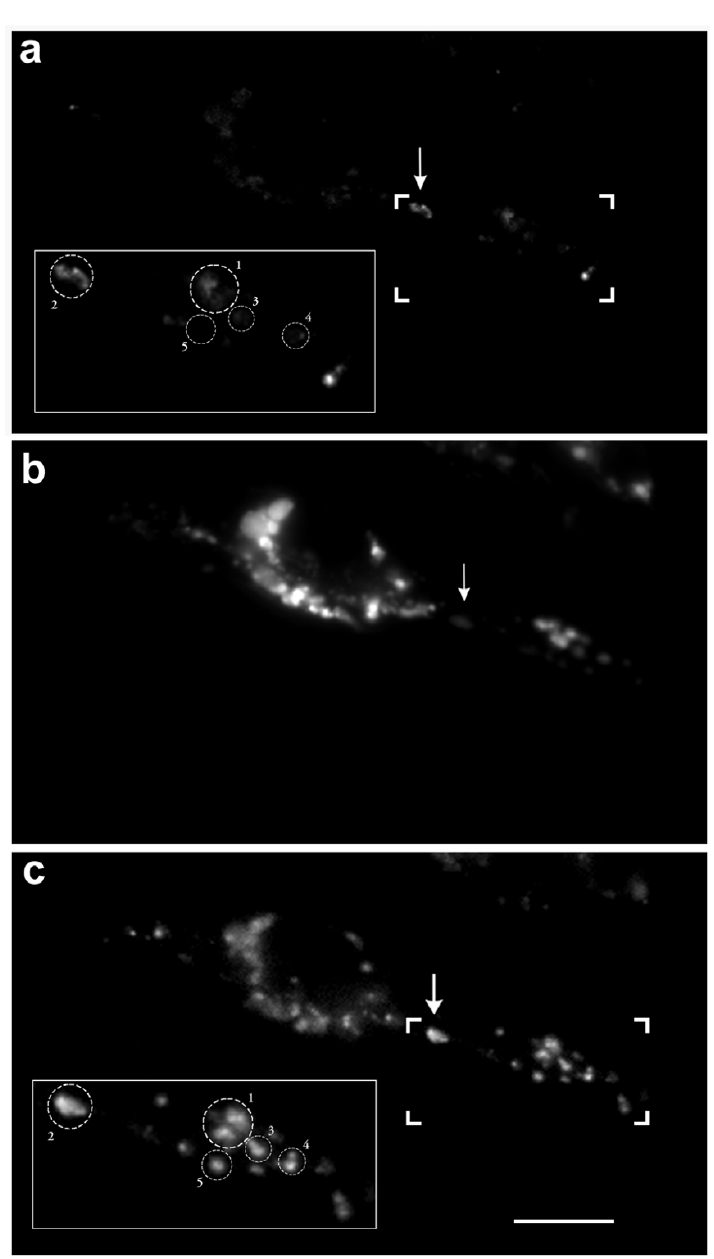
Figure 9 Heterogeneous distribution of oxidative activity in lysosomes is not due to heterogeneous distribution of the OxyBURST Green H 2 HFF BSA Cell monolayers were grown on circular glass coverslips and labeled with OxyBURST Green H 2 HFF BSA as described. The cells were then mounted onto a temperature control stage with a perfusion chamber for microscopy. The temperature was controlled at 37 ° C throughout the experiment. Cells were then treated with 200 nM PMA for 30 min, followed by 25 nM LysoTracker Red DND-99 for 5 min. Cells were then washed with PBS and the fluorescence images of both oxidized OxyBURST Green H 2 HFF BSA and LysoTracker Red were acquired. As shown in the panel A, oxida- tion activity is high in a subset of lysosomes (a, see arrow), which accumulate little LysoTracker Red (b). To oxidize all the OxyBURST Green H 2 HFF BSA in the same cells, H 2 O 2 was added to the chamber to a final concentration of 0.05% in PBS. The cells were then incubated for an additional 15 min to allow oxidation of all the lysosomal OxyBURST Green H 2 HFF BSA. Afterwards, the fluorescent image of oxidized OxyBURST Green H 2 HFF BSA from the same cell was then recorded as shown in (c). Bar, 10 µ